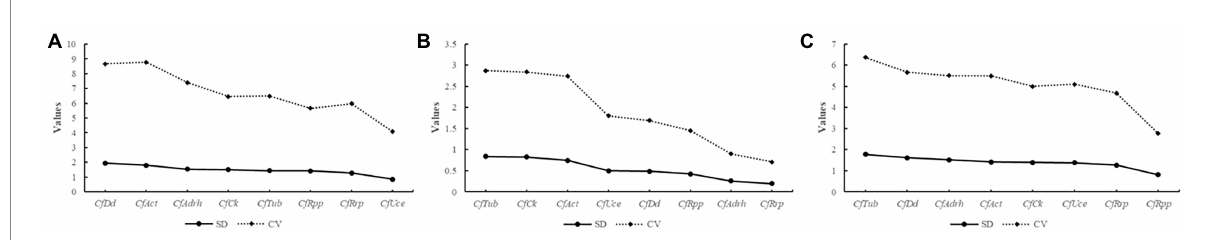
FIGURE 5 BestKeeper analysis of expression stability of eight candidate reference genes in different groups. (A) Mycelial growth; (B) HJ leaf spot group; and (C) HS leaf spot group. Standard deviation (SD) and coefficient of variation (CV) of Cq values for each gene were calculated. Stable reference genes have relatively low variability and standard deviation (CV ± SD).